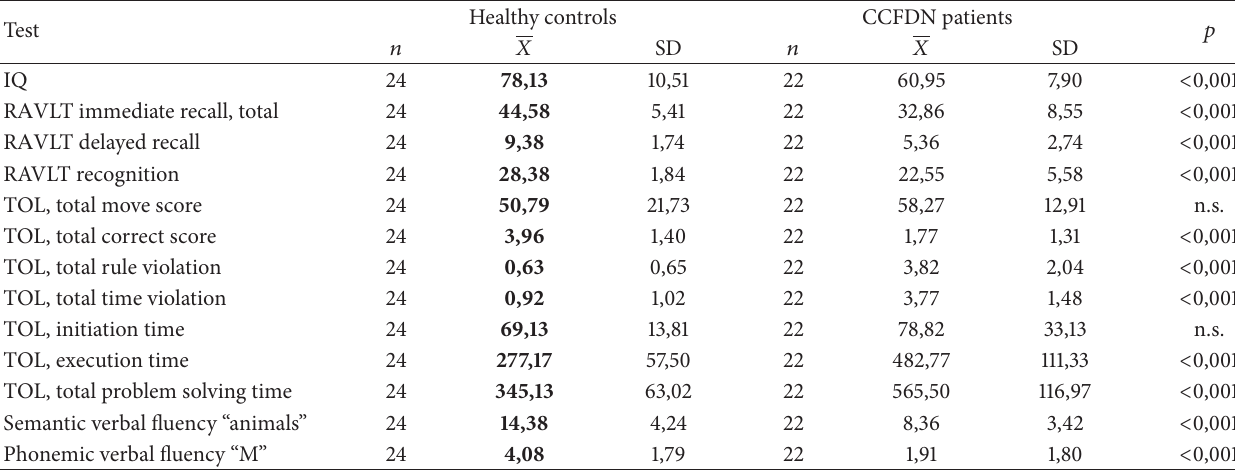
Table 3: Comparative analysis of the results of the neuropsychological tests between patients with CCFDN and healthy control group. Test